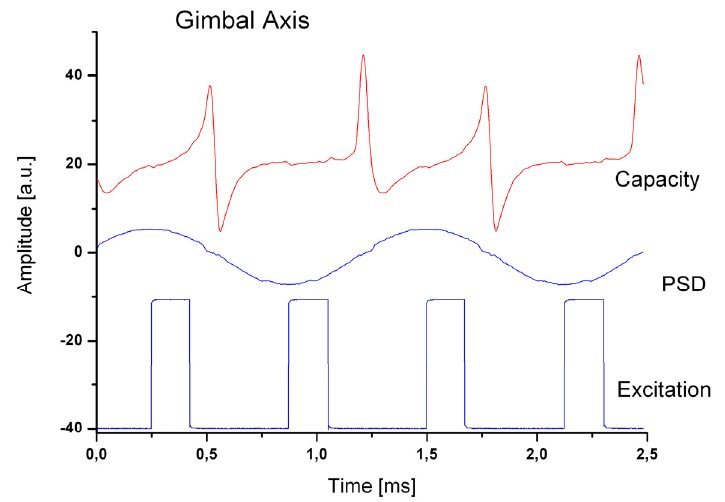
Figure 19. Measured capacitive feedback signal over time in comparison with optically measured PSD output signal and driving pulse signal applied on the gimbal comb